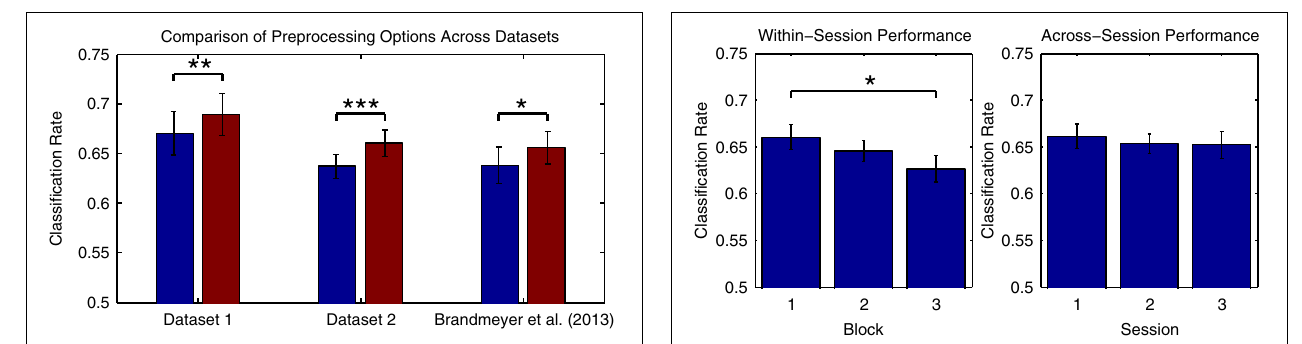
FIGURE 5 | Comparison of performance across measurement blocks and sessions. Classification rates obtained using individual measurement blocks from Dataset 2 were compared. While no significant difference in performance was found for the initial blocks in each of the three sessions, a significant decrease in performance from the first to the third block of the first session was observed. This may be due to a number of factors, including response habituation and experimental fatigue, both of which have been shown to influence ERP classification performance (Sellers and Donchin, 2006; Salvaris and Sepulveda, 2009). Such effects should be carefully considered during the design of experiments and procedures that make use of ERP classification. The significance of paired-sample t -test comparisons is indicated using asterisks: ∗ p < 0 .